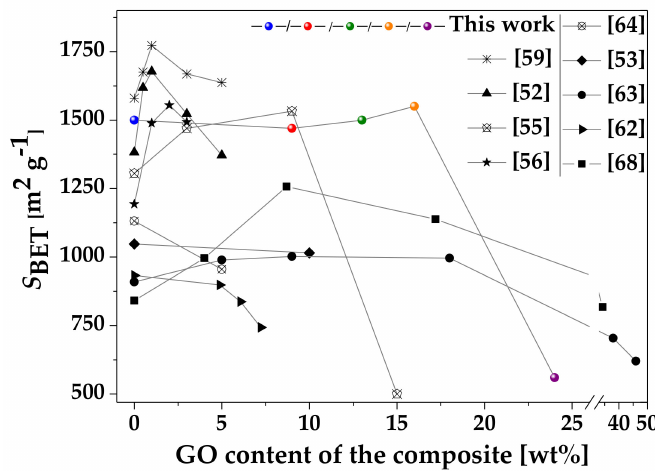
Figure 5. Influence of GO content on the apparent surface area of the associated HKUST-1@GO. Comparison of the present results and reference data.